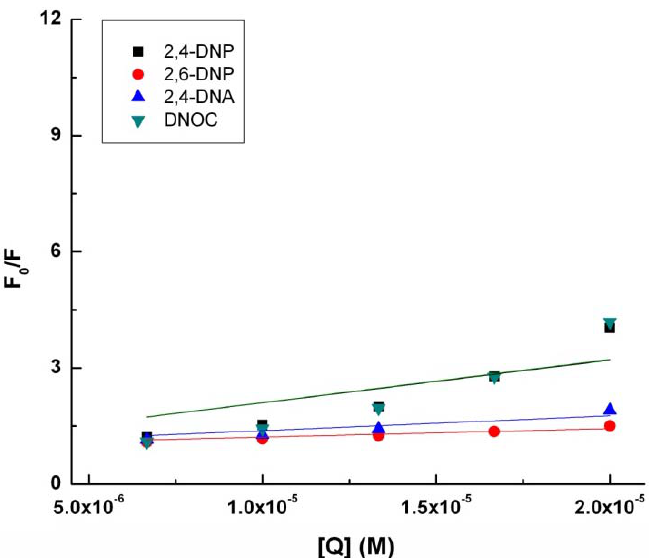
Figure 2. Modified Stern-Volmer plot for the binding of 2.4-DNP, 2.6-DNP, DNA, and DNOC to